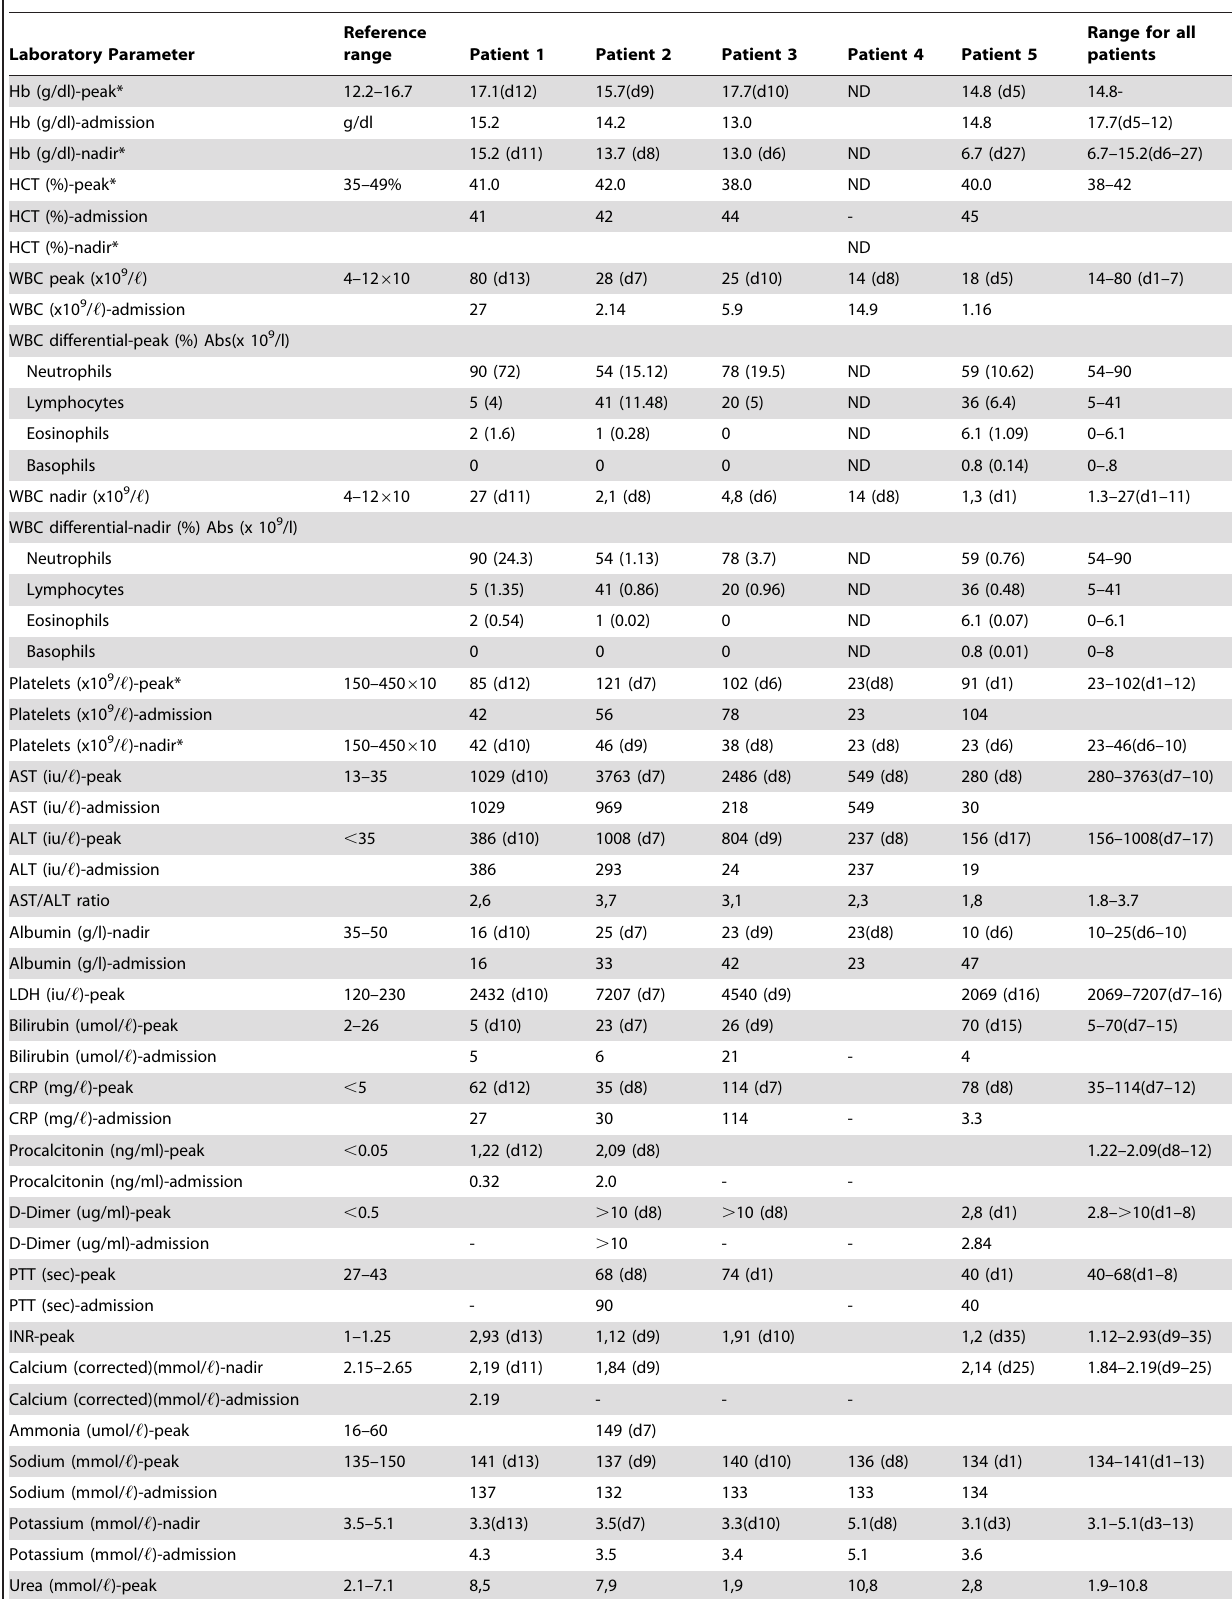
Table 2. Clinical laboratory parameters in 5 patients with Lujo hemorrhagic